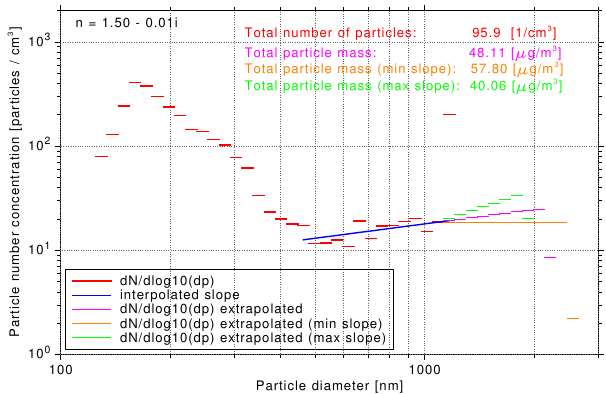
Fig. 3. Example for the extrapolation procedure described in Sect. 2.2 for an OPC measurement inside the volcanic cloud on 19 May 2010 11:14UTC and a refractive index of n =1.50–0.01i. The red bars show the measured size distribution. The blue line shows the linear fit for particles > 450µm while the magenta bars show the extrapolated “virtual size” channels. The orange and green bars show the extrapolated size distribution using the minimum and maximum slope as determined from all measured ash size distribu- tions (see Sect.